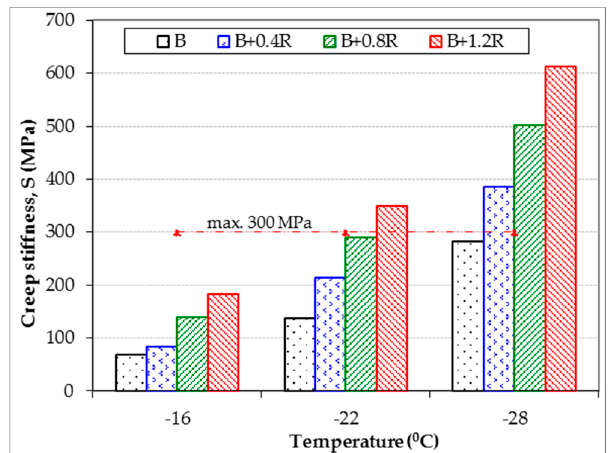
Figure 15. Effects of Elvaloy ® RET on the creep stiffness of B 160/220.